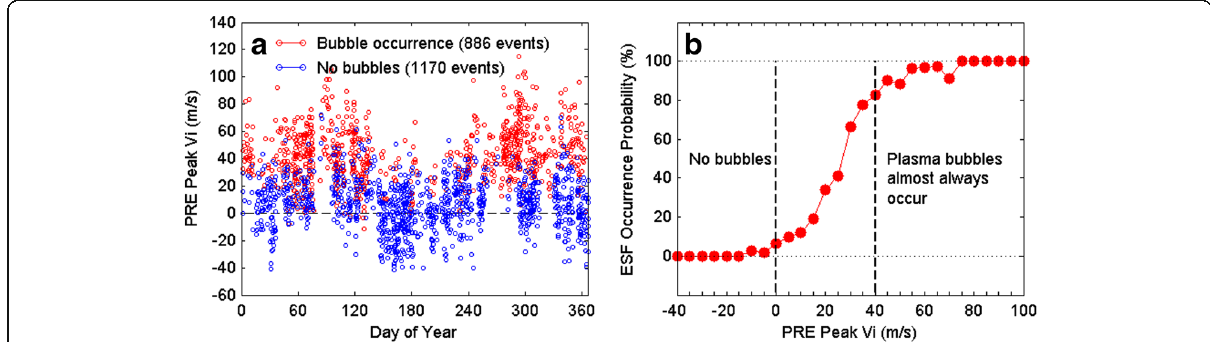
Fig. 7 a The vertical ion drift at the PRE peak in the cases with plasma bubbles (red circles) and in the cases without plasma bubbles (blue circles) detected by C/NOFS during May 2008 – June 2013. b The dependence of the plasma bubble occurrence probability on the vertical ion drift at the PRE peak. (After Huang and Hairston